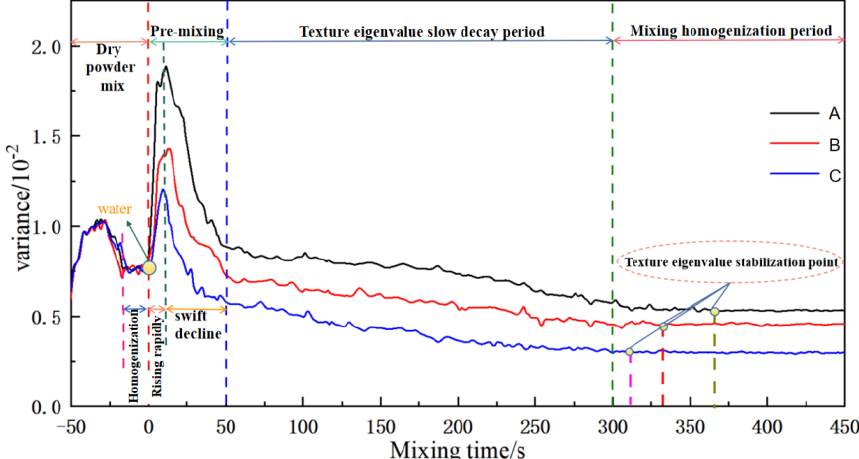
Figure 8. Comparison of the difference after denoising treatment of each test group. As show in Figures 7 and 8, the surface layer has dry tailings before mixing (Figure 7a). As the image color and surface texture are uniform, and the image grayscale values are concentrated, the texture feature values are relatively small. As the mixing went on, the cement and tailings are mixed with each other, which increases the surface difference of the material. Therefore, the texture feature value increases slightly. With the addition of water, tailings and cement particles are bonded into agglomerates under the action of the liquid bridge force of water, as shown in Figure 7c. At that time, the surface texture of different size of particle clusters is more chaotic. There are even some shadow areas in the images, where the grayscale distribution range is wider, which means that the shape of the grayscale distribution curve becomes “short and fat”. In this process, the curve changes rapidly. In the experiments of the three groups, the curve rapidly becomes “fat” within 30 s after adding water, and the variance reaches its peak. Under the further action of mixing and shearing, the agglomerated materials are gradually sheared and dispersed. The tailings, cement, water, and agglomerated particles that continued to adsorb water were broken and dispersed under the action of mixing and initially homogenized, which presented a “paste-like” form (as shown in Figure 7h). Finally, the texture feature value decreases rapidly. With further shearing, the three-dimensional structure of the finer particle flocculation and the slurry is destroyed and it releases the internal wrapped water. The material gradually takes the shape of a homogeneous paste with a relatively smooth surface and a consistent image texture (as shown in Figure 7i–l). The texture feature curve gradually reaches stability. At the same time, for the convenience of analysis and discussion, the study defines the time that the grayscale curve reaches its stability as the stabilization time ( Ts